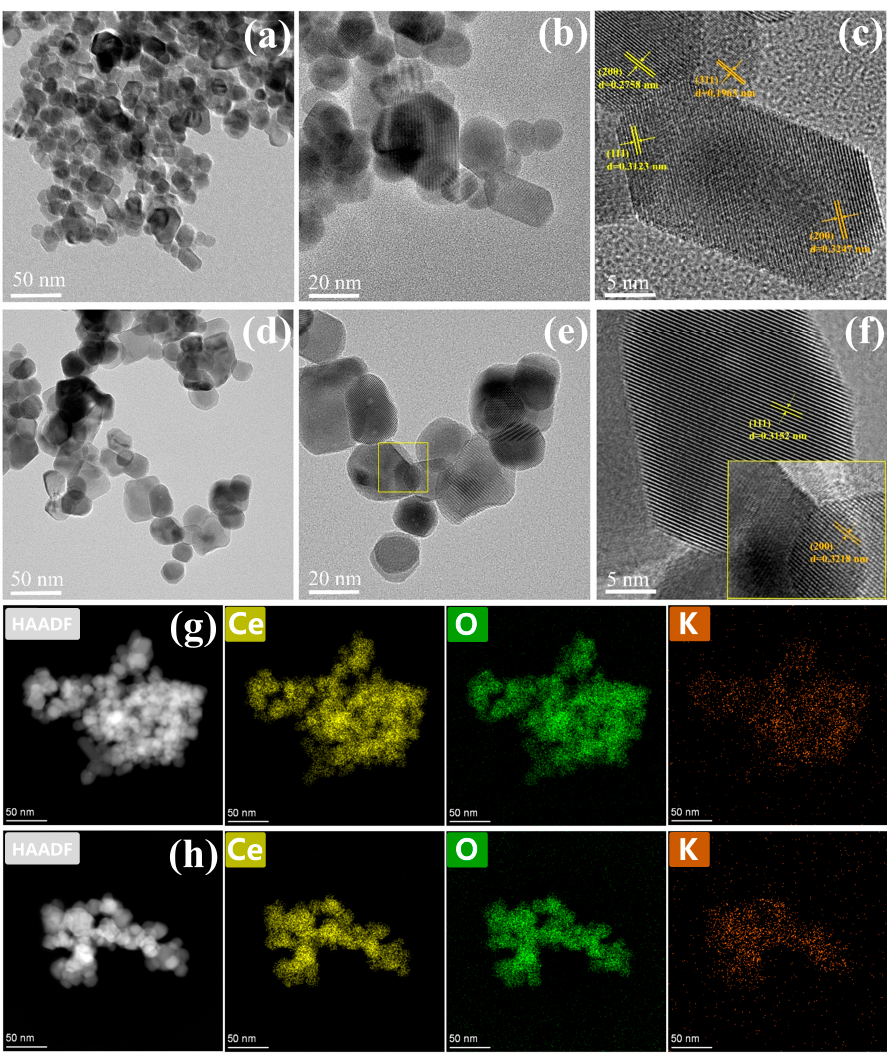
Figure 11. HRTEM and EDS of 10%K/CeO 2 before and after a 50 h stability test. ( a – c ) HRTEM of fresh 10%K/CeO 2 ; ( d – f ) HRTEM of 10%K/CeO 2 after a 50 h stability test; ( g ) EDS of fresh 10%K/CeO 2 ; ( h ) EDS of 10% EDS of K/CeO 2 .